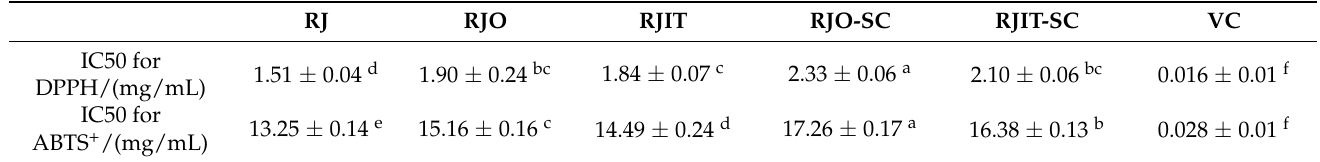
Table 4. Effect of I . terricola WJL-G4 on DPPH · and ABTS + · radical scavenging activities of red raspberry